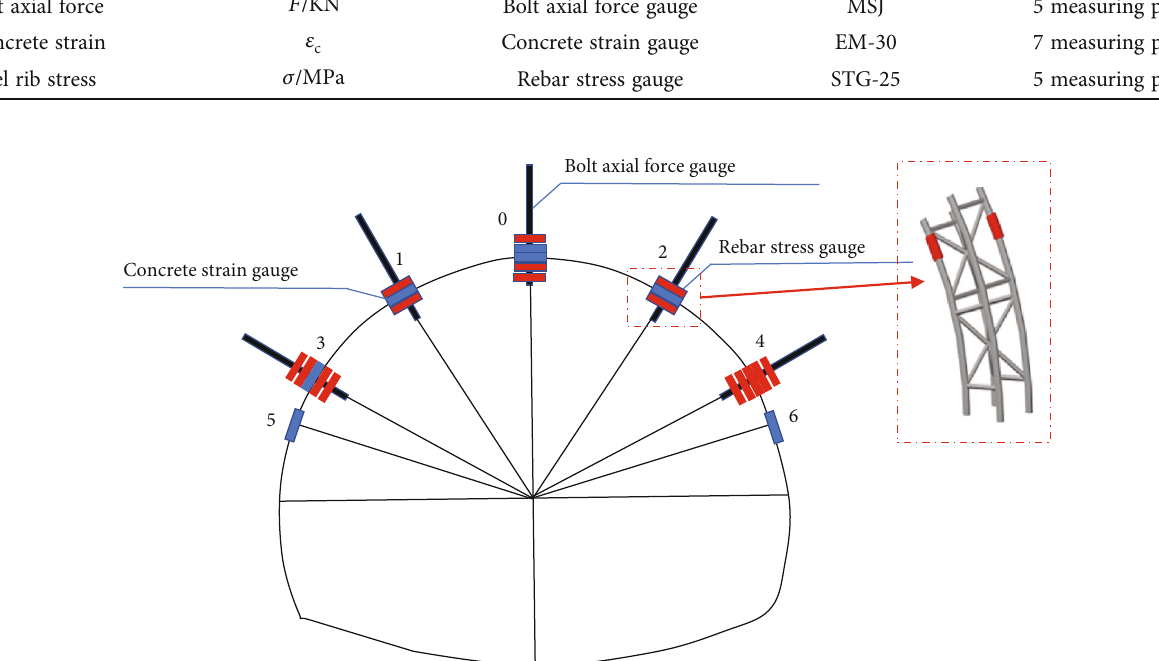
Figure 2: Layout of monitoring points and number of instruments at the test section.